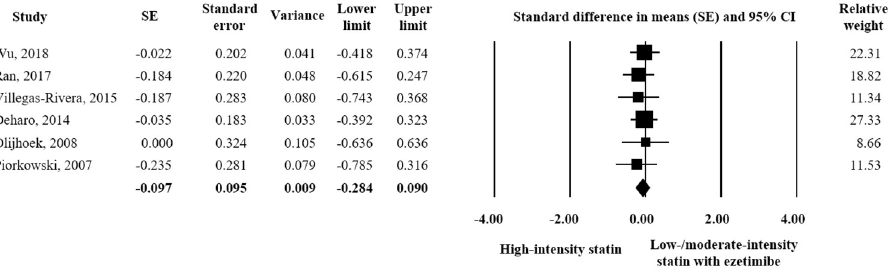
Fig 7. Forest plot of safety evaluation results. Changes in ALT observed for high-intensity statin monotherapy and low/moderate-intensity statin plus ezetimibe combination therapy.